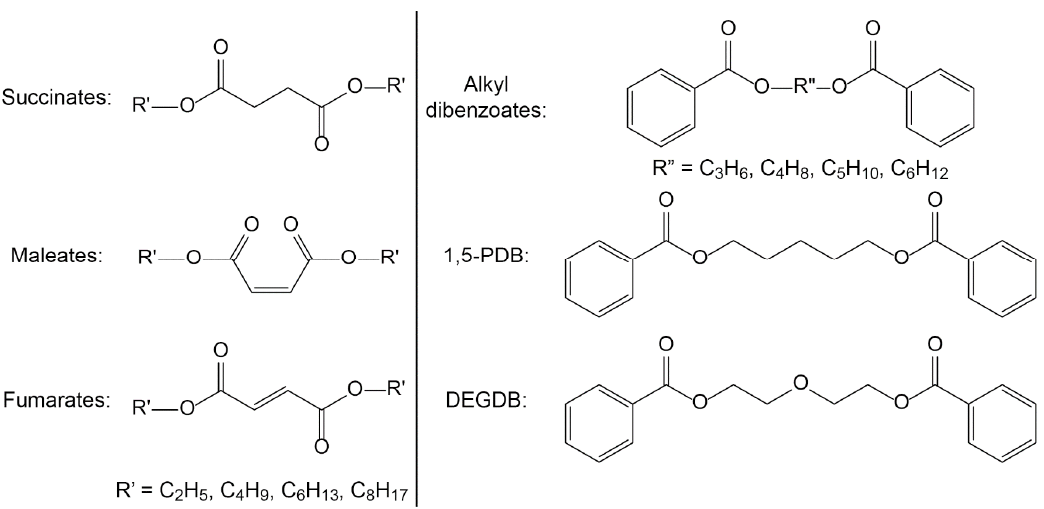
Figure 5. Candidate green plasticizer families: succinates, maleates, fumarates (all with unbranched side chains), and linear alkyl dibenzoates. The only difference between the dibenzoate 1,5-PDB and the commercial diethylene glycol dibenzoate (DEGDB) is the molecule in the center of the diol linker: carbon (in the case of 1,5-PDB) or oxygen (in the case of DEGDB). 1,5-PDB is 1,5-pentanediol dibenzoate, DEGDB is diethylene glycol